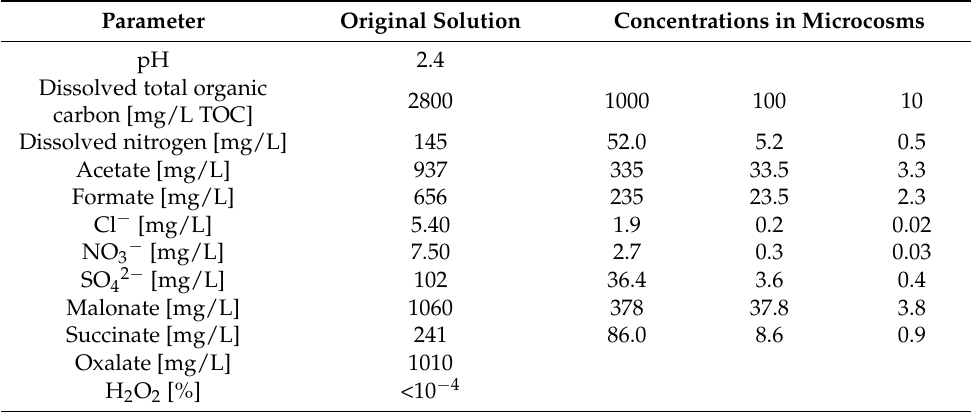
Table 1. Characteristics of chemically solubilized lignite